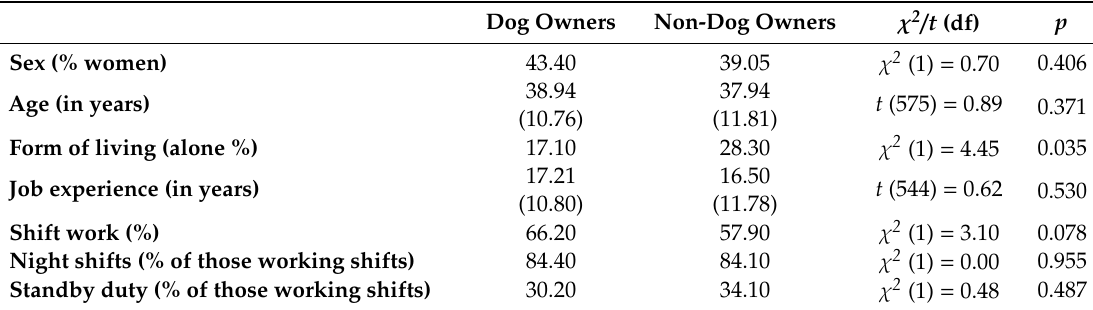
Table 1. Sample characteristics for dog owners and non-dog